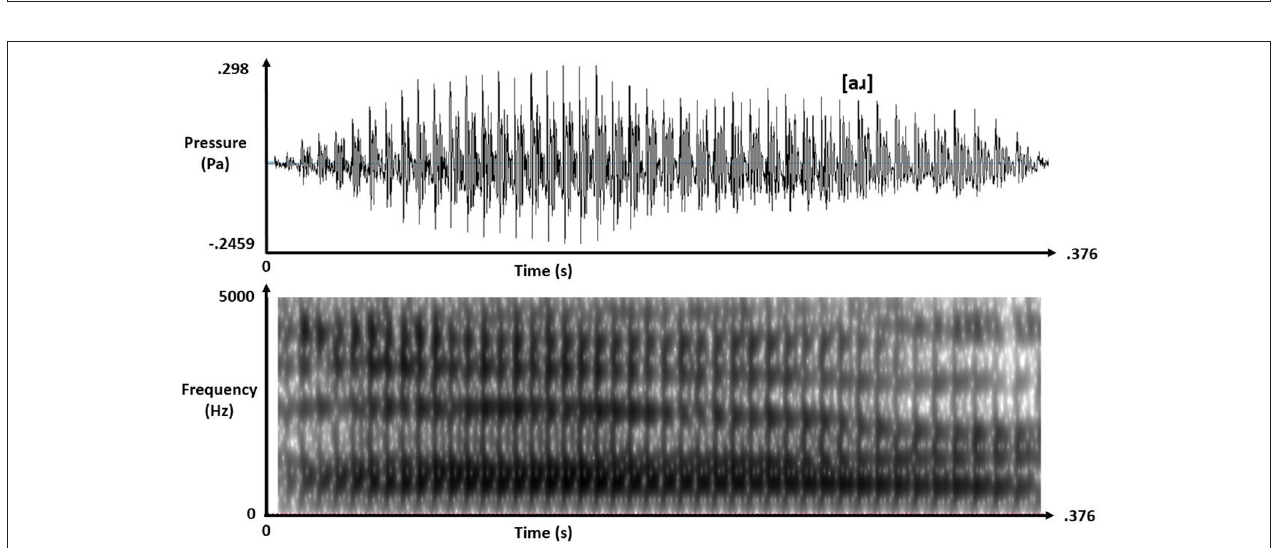
FIGURE 2 | Audio waveform (top) and spectrogram (bottom) for speech context [a ô